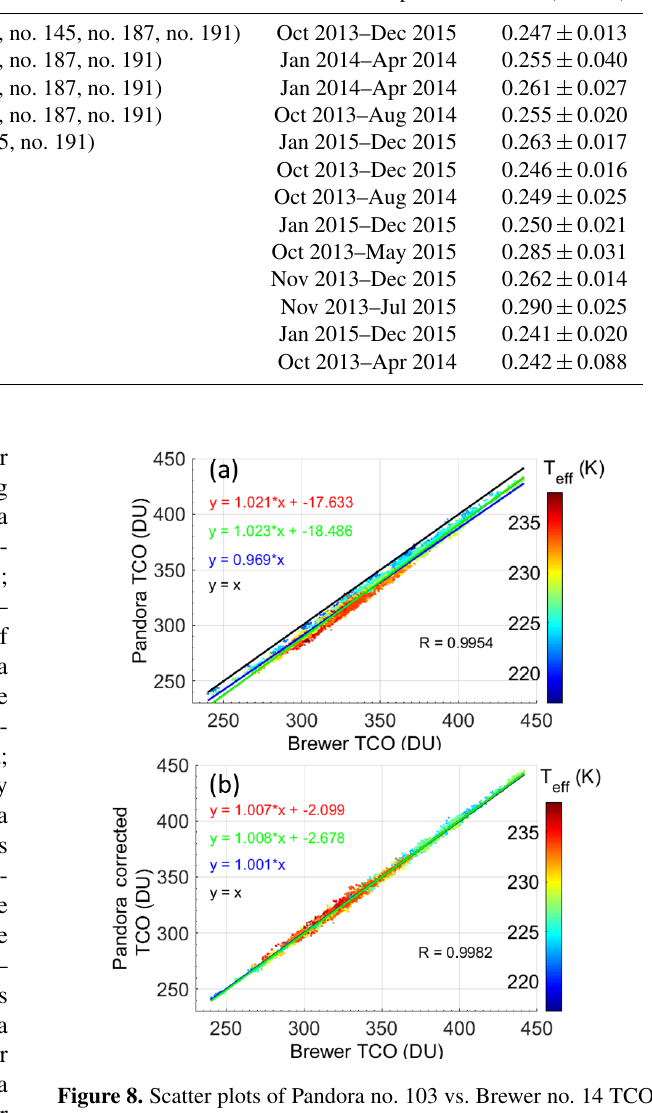
Table 3. Summary of sensitivity tests for Pandora relative temperature dependence factors. Test no.